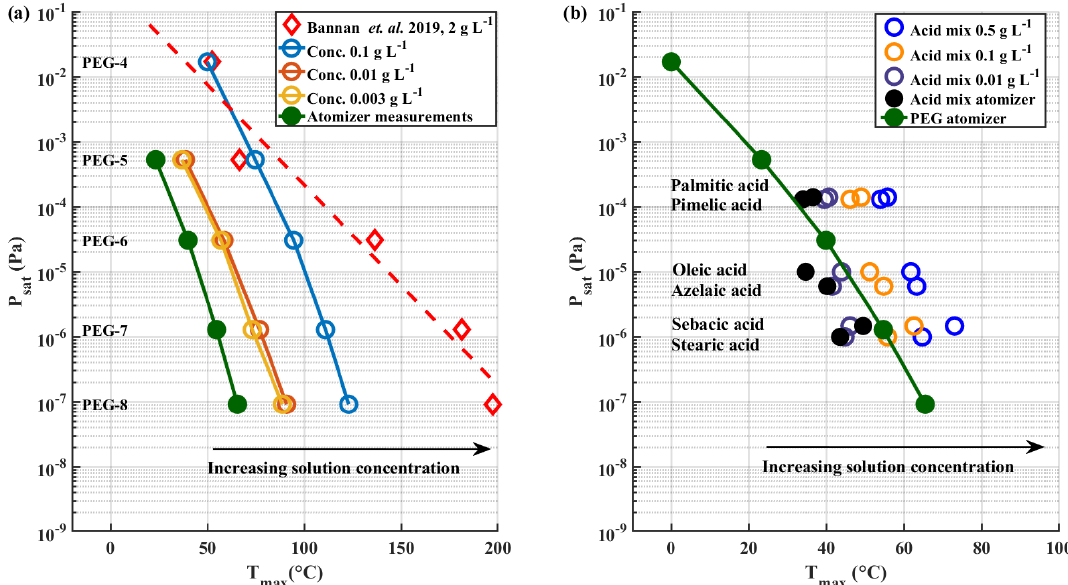
Figure 3. Solution concentration effect. Literature-based saturation vapour pressure P sat values are plotted vs. measured T max for (a) PEG compounds and (b) carboxylic acids with a logarithmic y axis. Black arrows in both panels indicate the direction of shift in T max values as the solution concentration increases. PEG atomizer results are also included in panel (b) for reference.